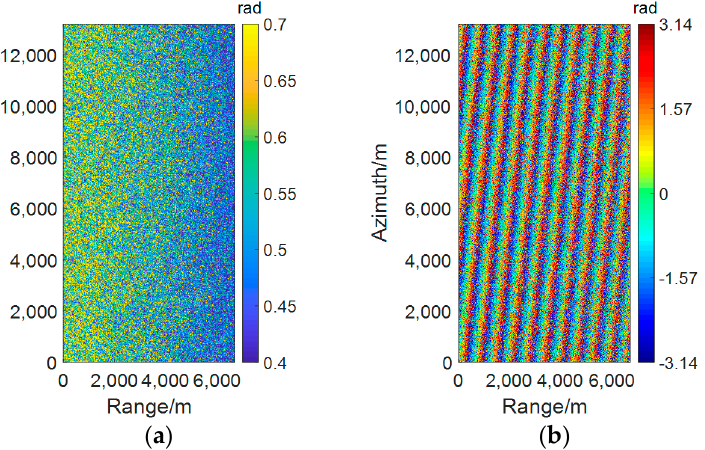
Figure 5. The correlation coefficients between the TerraSAR-X image and the TanDEM-X image in A 4 ( a ) and the interferogram in A 4 ( b ). ( a ) and the interferogram in A 4 ( b